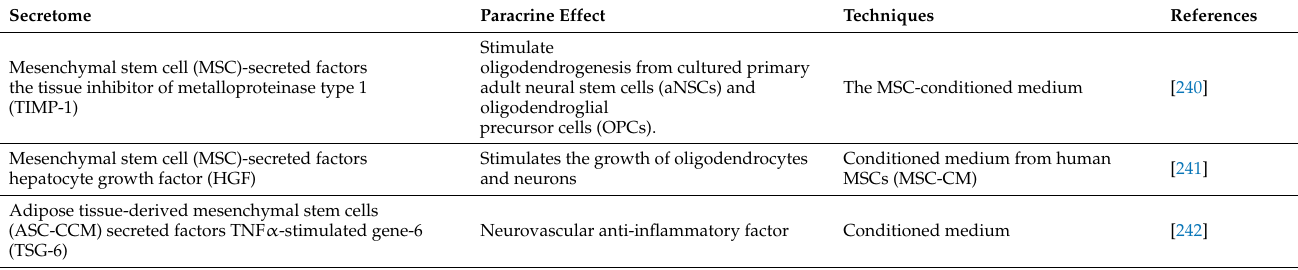
Table 2. A summary of recent studies reported the paracrine effect of stem cells secretomes, exosomes, microvesicles, and extracellular vesicles on neurological